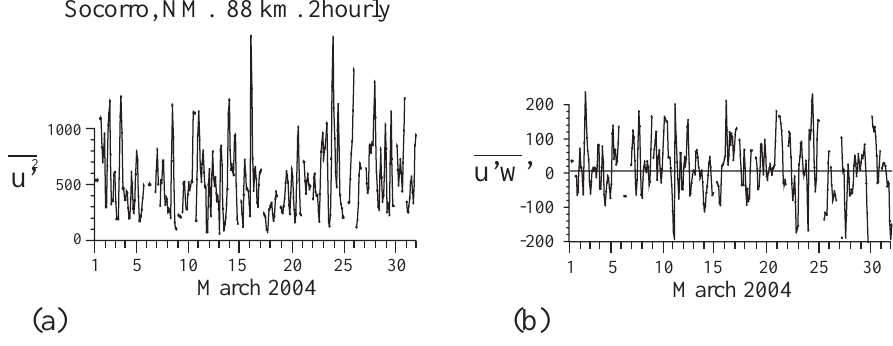
Fig. 2. Socorro data using 3-h bins and 2-h steps. Slightly different parameters are shown compared to Fig. 1, just to illustrate that all flux terms are available. Quality has improved significantly compared to Fig. 1.